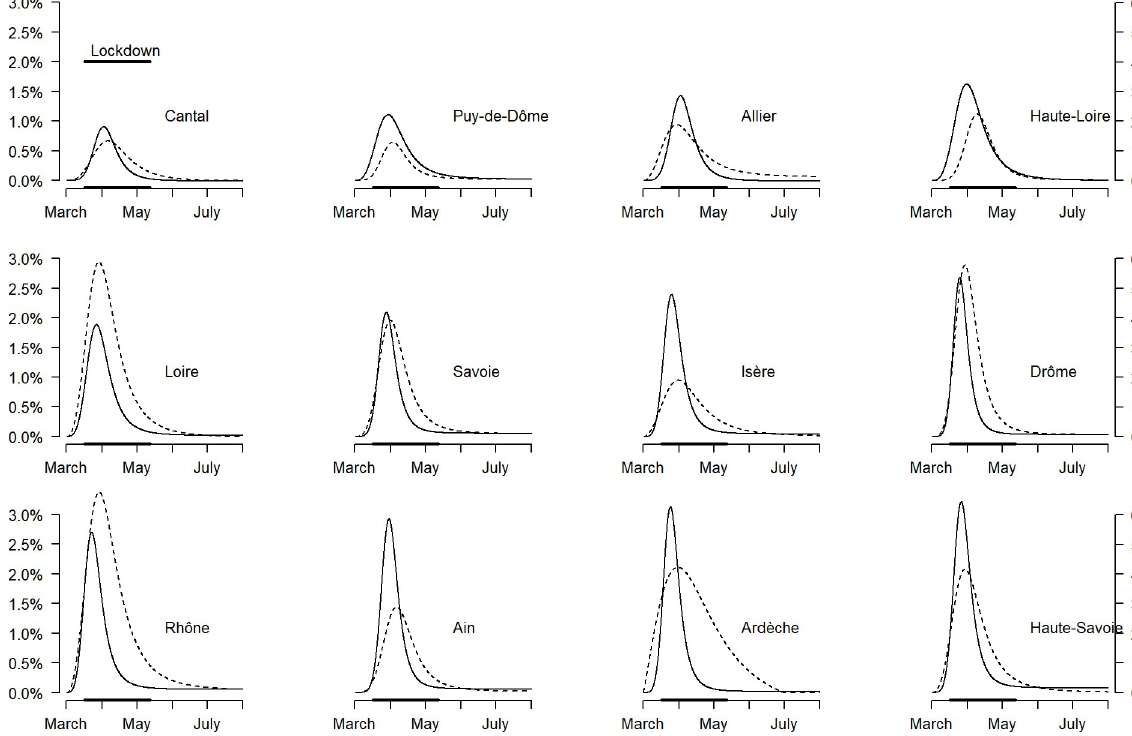
Fig 3. Modelled curves of daily outbreak probabilities of COVID-19 in the nursing homes of each Département (solid line) and daily hospitalization probabilities in each Département population (dotted line) according to the time elapsed since March 1, 2020, France. The curves are ranked in an increasing order of height of the peaks of outbreak probabilities in nursing homes. The left-hand y-axis corresponds to the daily probability of outbreak. The right-hand y-axis corresponds to the daily hospitalization probability per 100,000